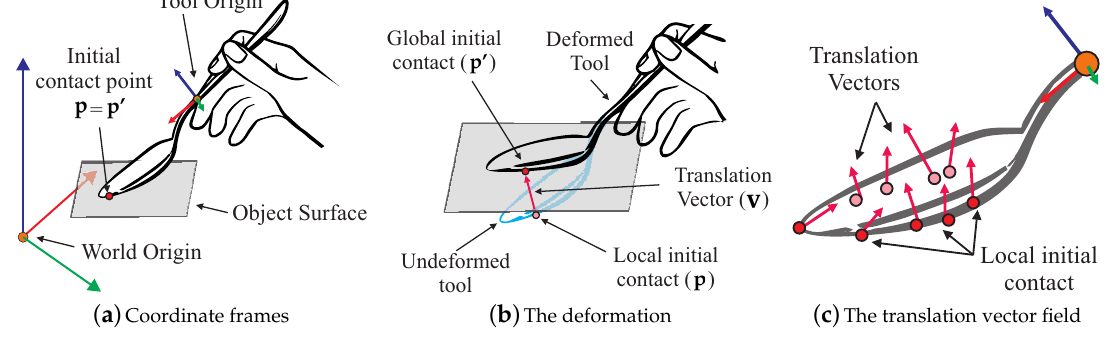
Figure 1. Descriptions of the model input space: ( a ) the input space is defined with respect to the origin of a tool; ( b ) a six-dimensional input vector consists of a position of an initial contact p and a translation vector, v that describes the state of deformation; ( c ) A set of recorded input vectors are used in interpolation, and the force response is approximated at the tool’s origin during